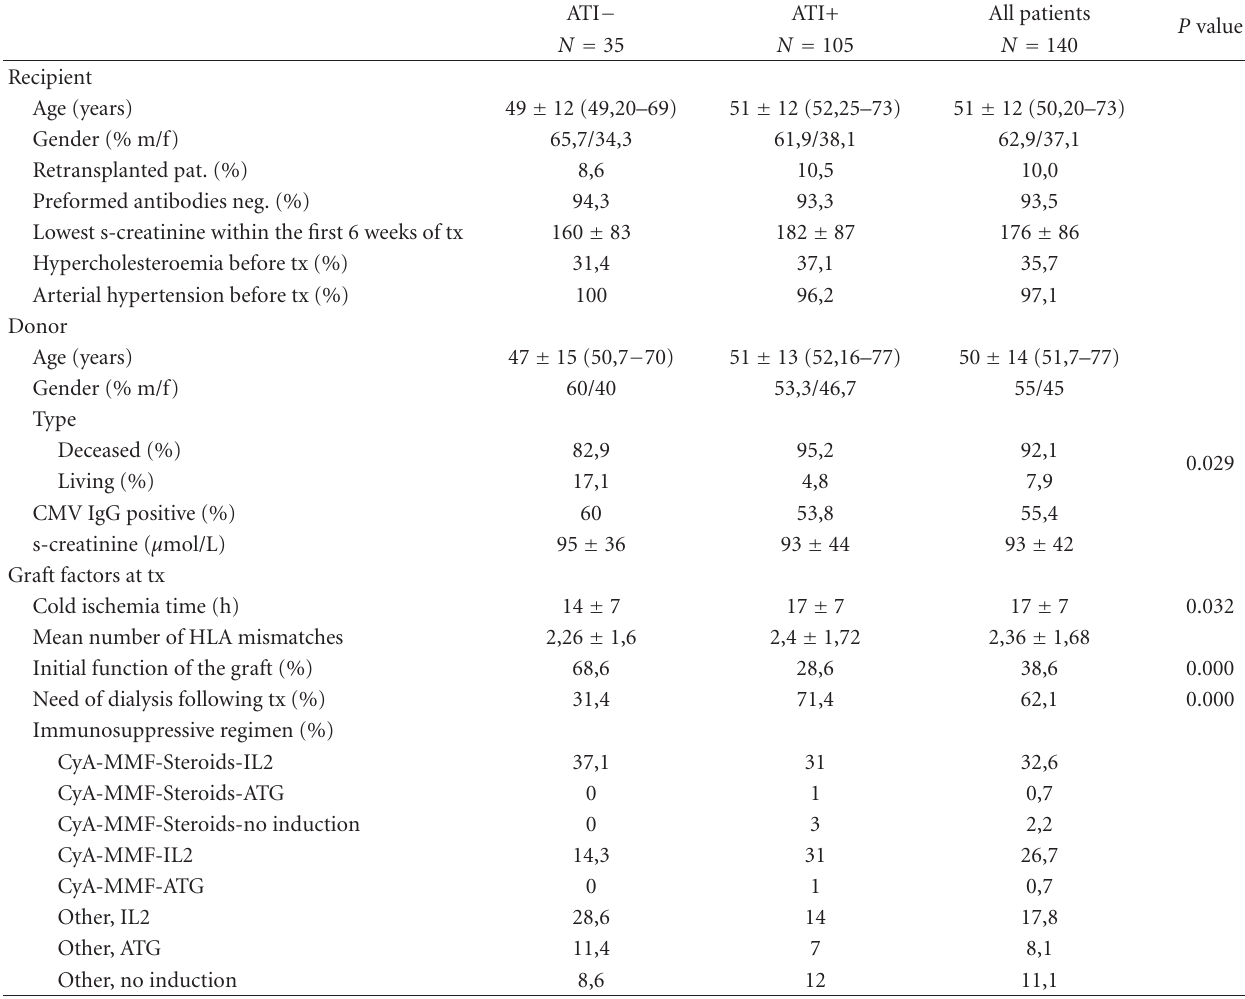
Table 1: Demographic and clinical data of patients with and without